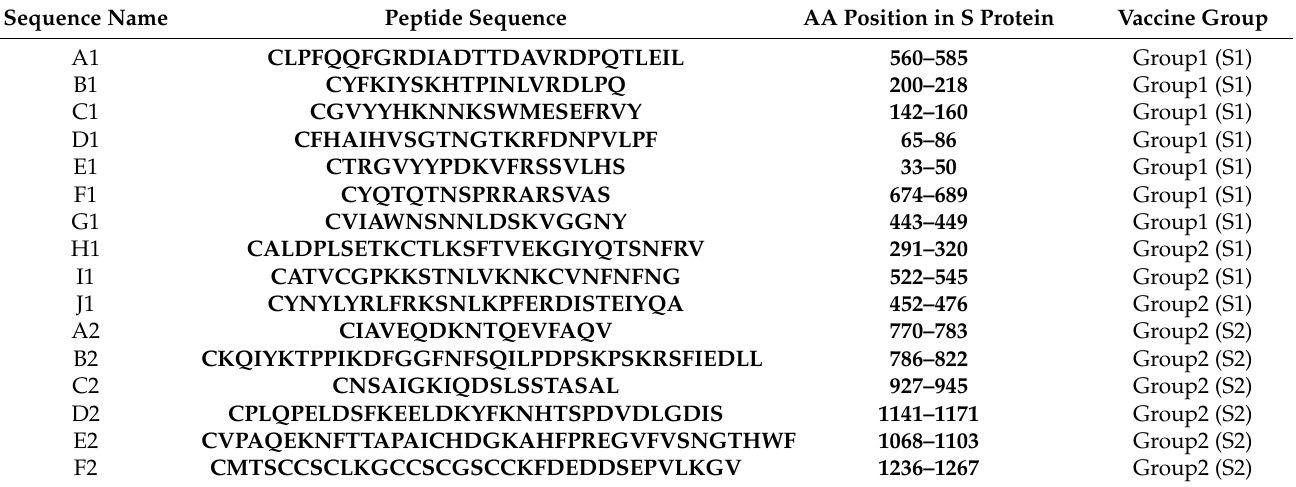
Table 1. Peptide sequence and their usage in the vaccination. A1-F2 are the peptide sequence names of each selected peptide. A cystine is added to the N-terminal of each peptide; AA position is the amino acid position in the whole S protein; vaccine group indicates the peptide mixture used for the